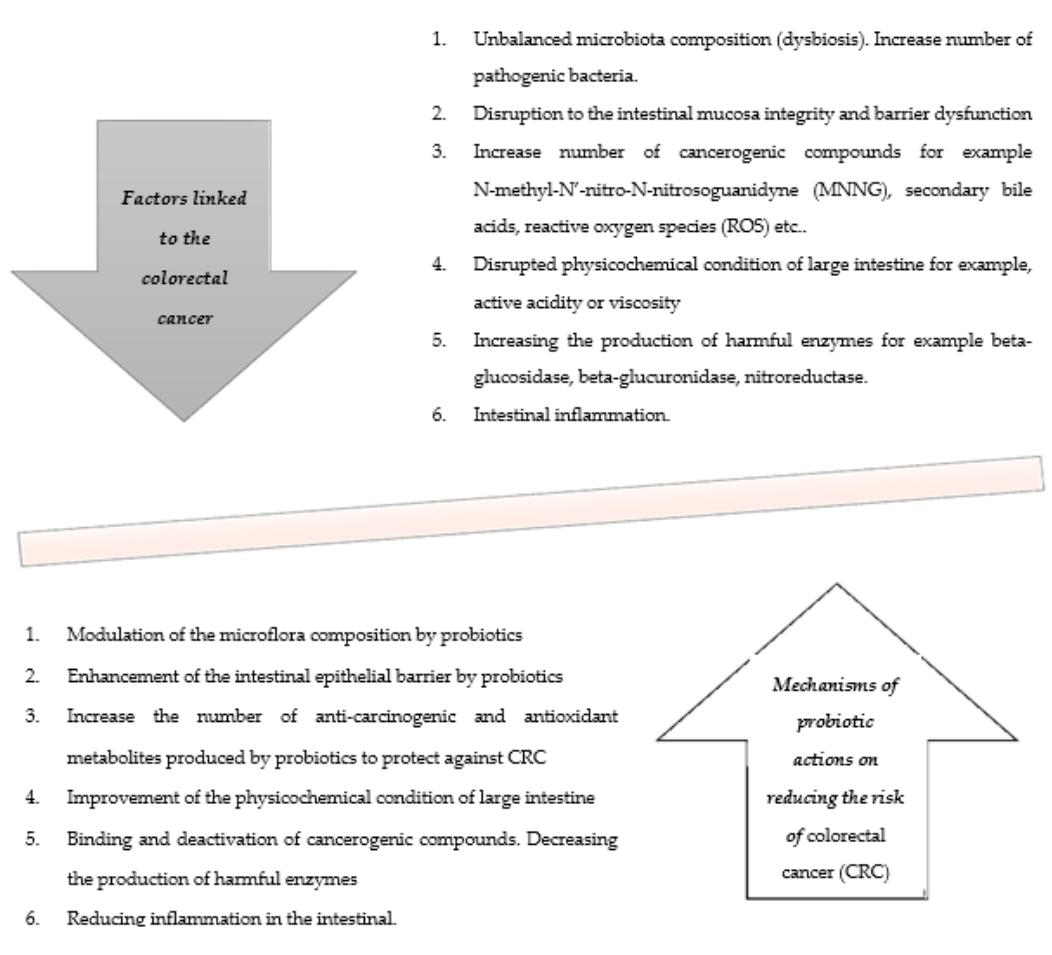
Figure 2. Potential mechanisms of probiotics action and factors related to CRC (colorectal cancer).